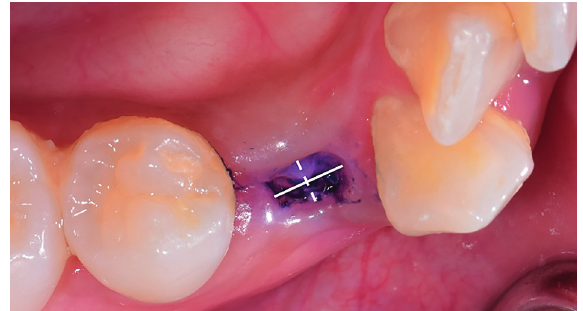
Figure 1: Measurement of wound socket in bucco-lingual and mesio-distal dimension using caliper. MD (thick line), mesio-distal measurement; BL (dashed line), bucco-lingual measurement.